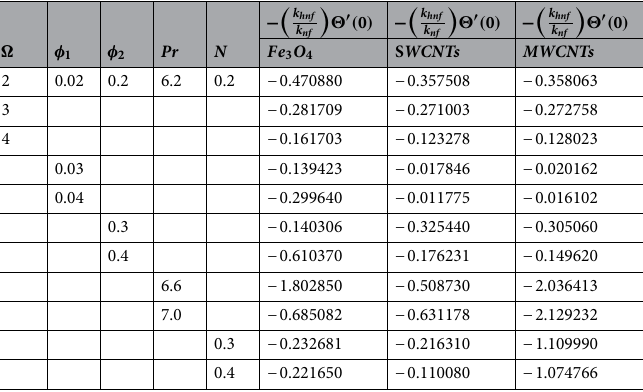
Table 5. The outcomes for Nusselt number −